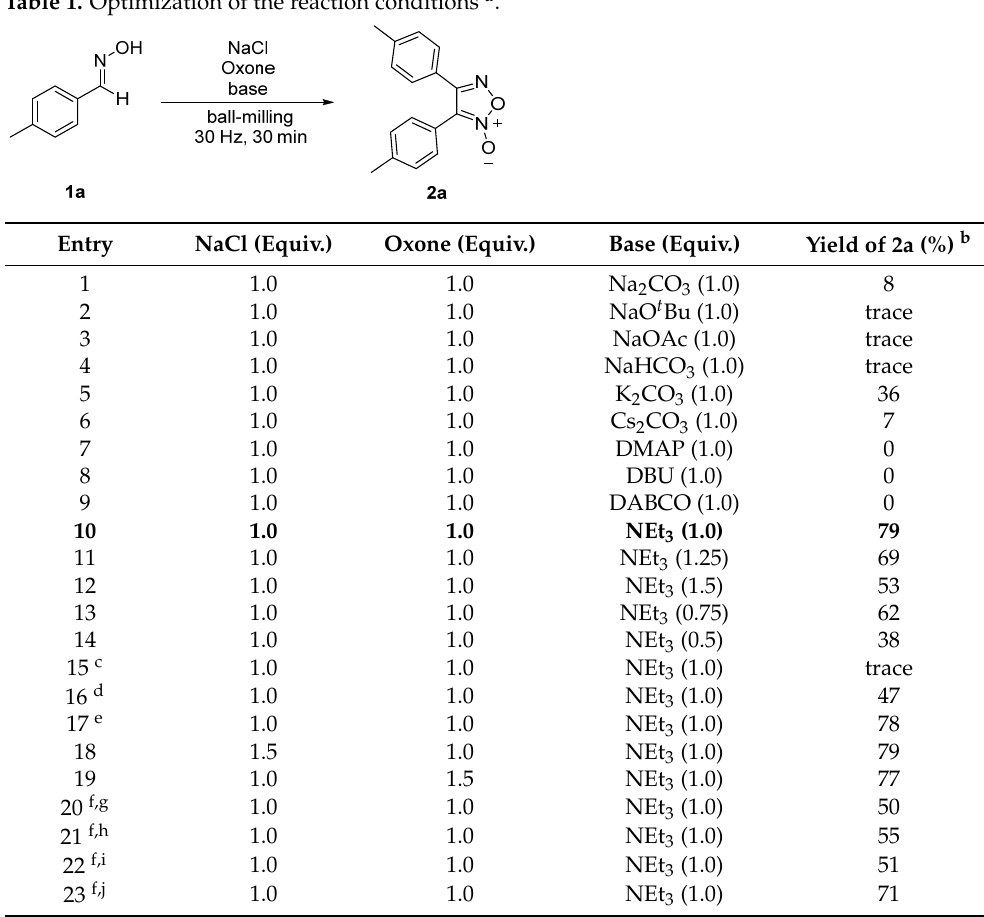
Table 1. Optimization of the reaction conditions a .